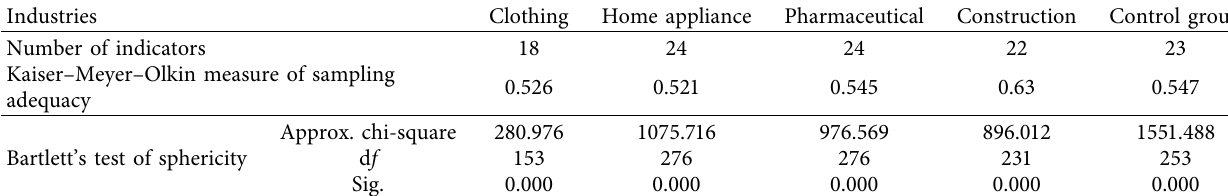
Table 3: KMO and Bartlett’s